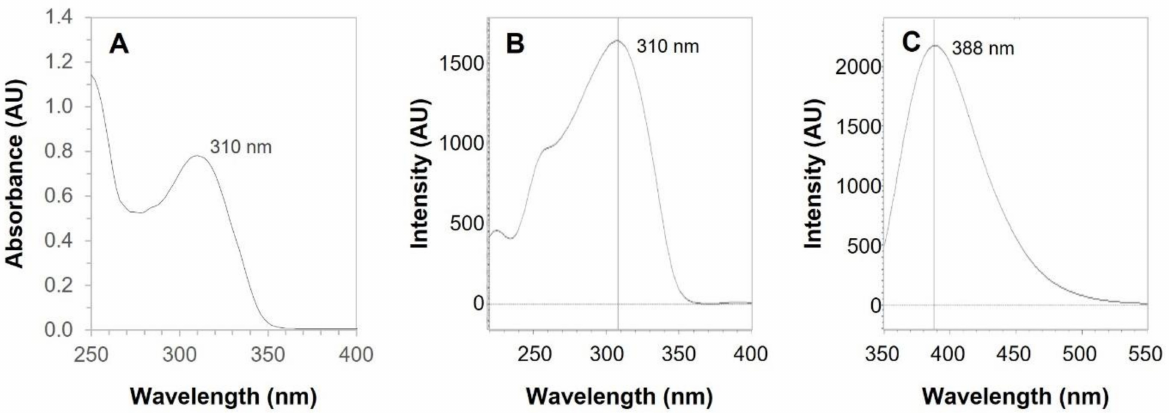
Figure 3. ( A ) Absorption spectrum of BCT in Transcutol. ( B ) Excitation spectrum of BCT in Transcutol. ( C ) Emission spectrum of BCT in Transcutol.